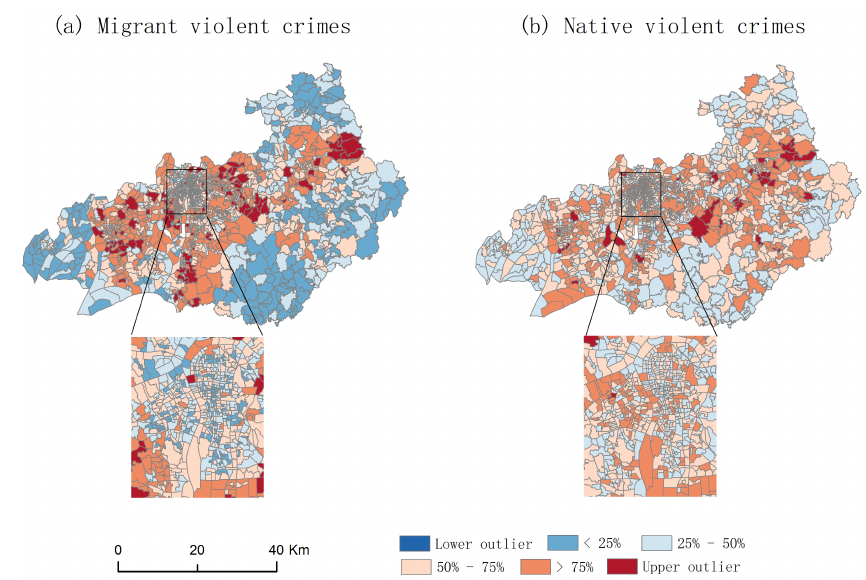
Figure 2. Box maps for different violent crimes at the neighborhood level in the whole city and in the old town. ( a ) Migrant violent crimes; ( b ) Native violent crimes.